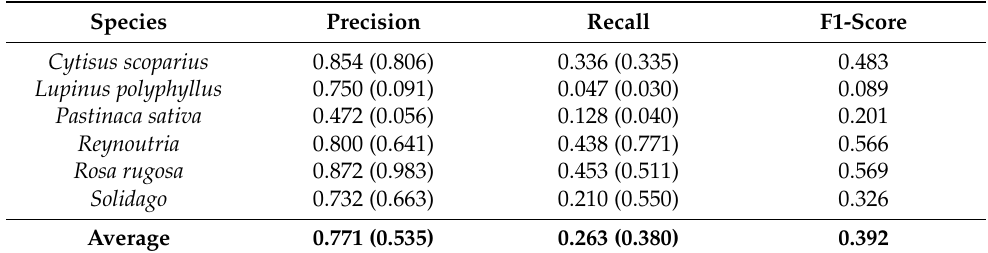
Table 6. Precision, recall and F1-score for the YOLOv3 model predicted on the test data set with a confidence threshold of 25% based on predictions in Table 5. ResNet50V2 precision and recall in parenthesis to compare the performance of the two